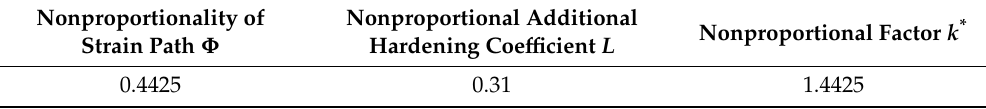
Table 6. Nonproportional parameters in the modified FS model.